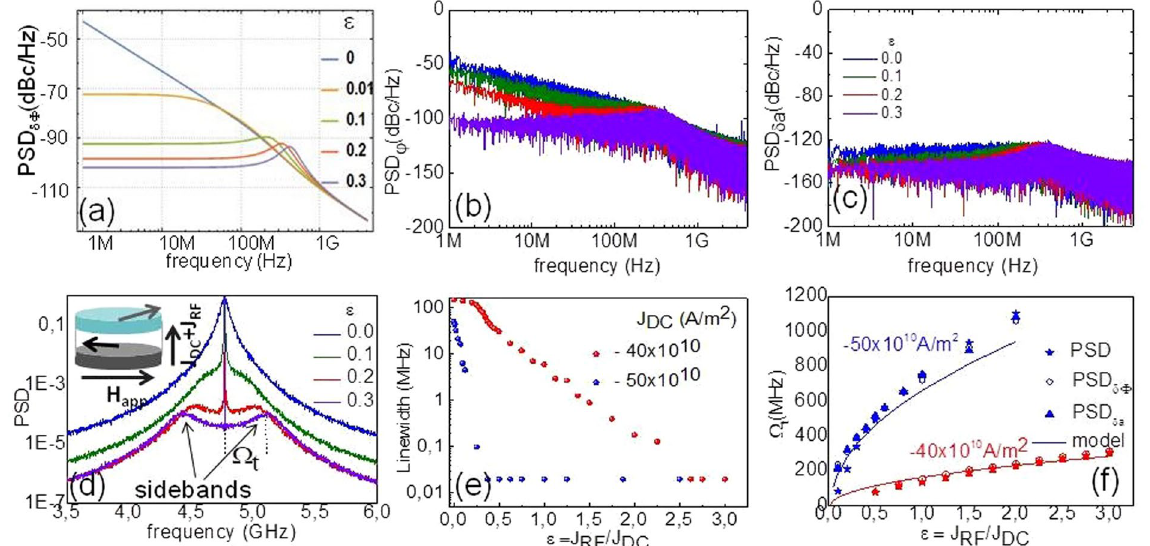
Figure 1. Phase noise calculated from the analytic model ( a ) and numerical simulations at 50 K for the phase ( d ) and amplitude ( c ) noise. Notice the peaks appearing ~200–300 MHz. ( d ) PSD of the signal as a function of ε for J DC = − 50 × 10 10 A/m 2 and schematics of the oscillator (inset). ( e ) Linewidth vs. ε for low current J DC = − 40 × 10 10 A/m 2 (red dots) and medium current J DC = − 50 × 10 10 A/m 2 (blue dots). For ε > 0.3 (medium J DC regime), the linewidth falls below the resolution of the technique.(f) Sideband frequency for both low current regime (red set) and medium current regime (blue set) extracted from the PSD (stars), and from